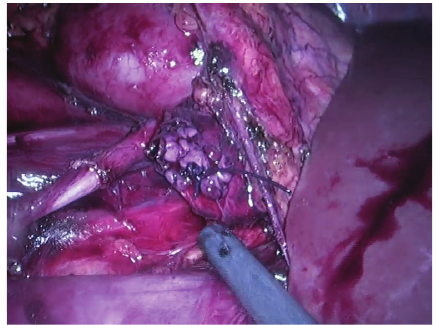
Figure 6: Final look of the anastomosis after inspection.